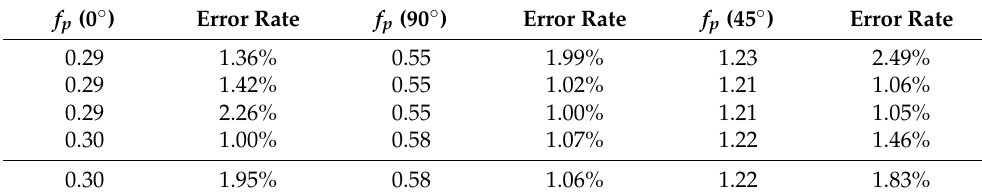
Table 5. The relative error ratio of the three